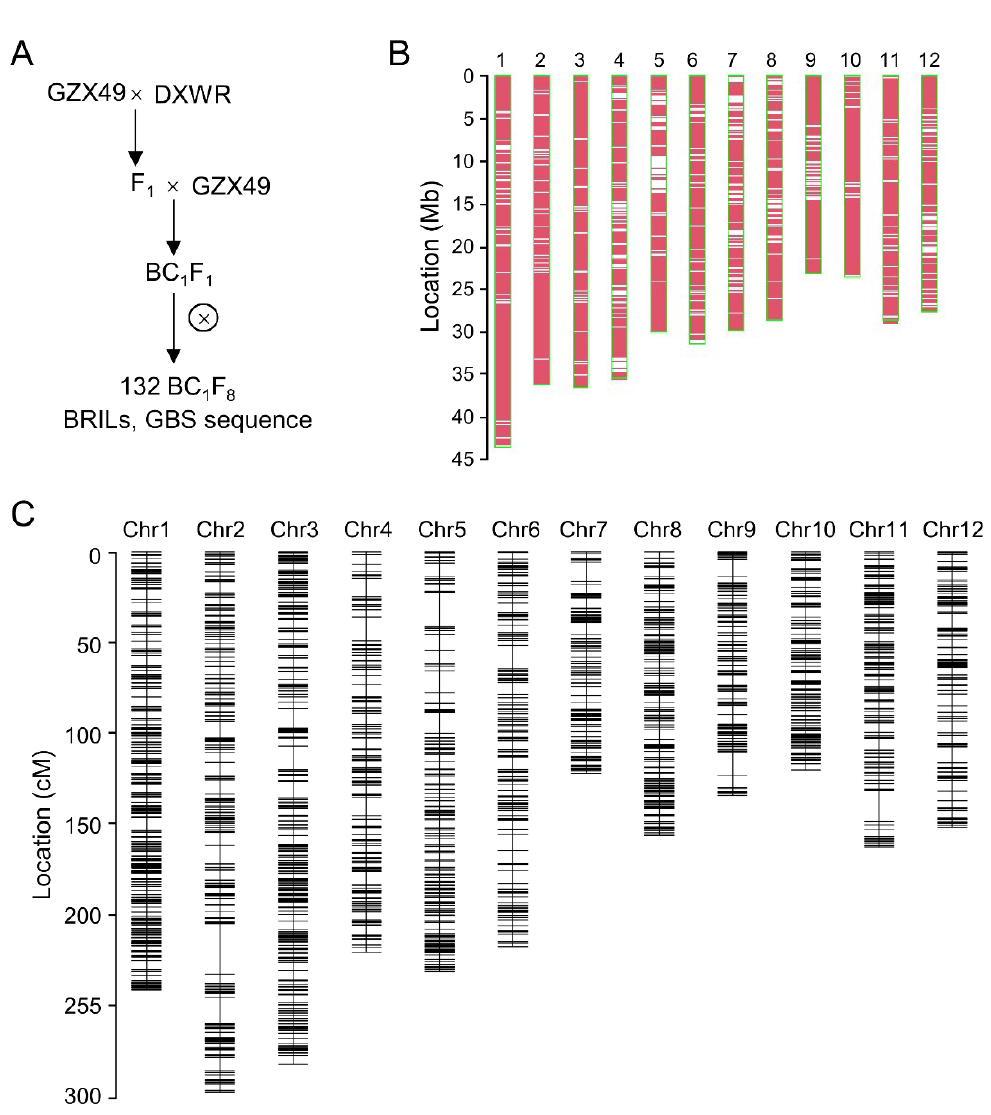
Figure 1. Development and construction of high-density bin map of BRILs. ( A ) Flowchart of devel- oping backcross recombinant inbred line (BRIL) population. ⊗ represents self-cross. ( B ) Polymorphic SNPs between DXWR and GZX49 distributed on chromosomes. ( C ) Genetic linkage map constructed by population BRILs.